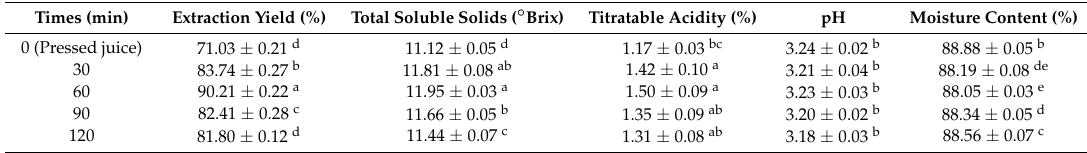
Table 2. Juice yield, TSS, TA, pH, and moisture content (mean ± SD) of mulberry juice at different ultrasonic times at a fixed temperature of 60 ◦ C.